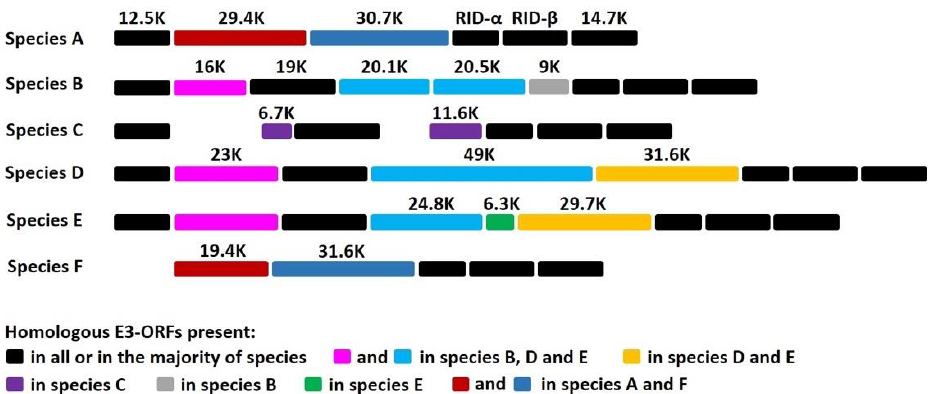
Figure 1. Sequence alignment showing the coding potential of E3 regions of the most common HAdVs-A, -B, -C, -D, -E, and -F. The expected molecular mass of each gene product is indicated. Proteins with amino acid sequence homology, generally ~35%, have the same shade coding: 19.4K and 31.6K are unique to HAdV-F.